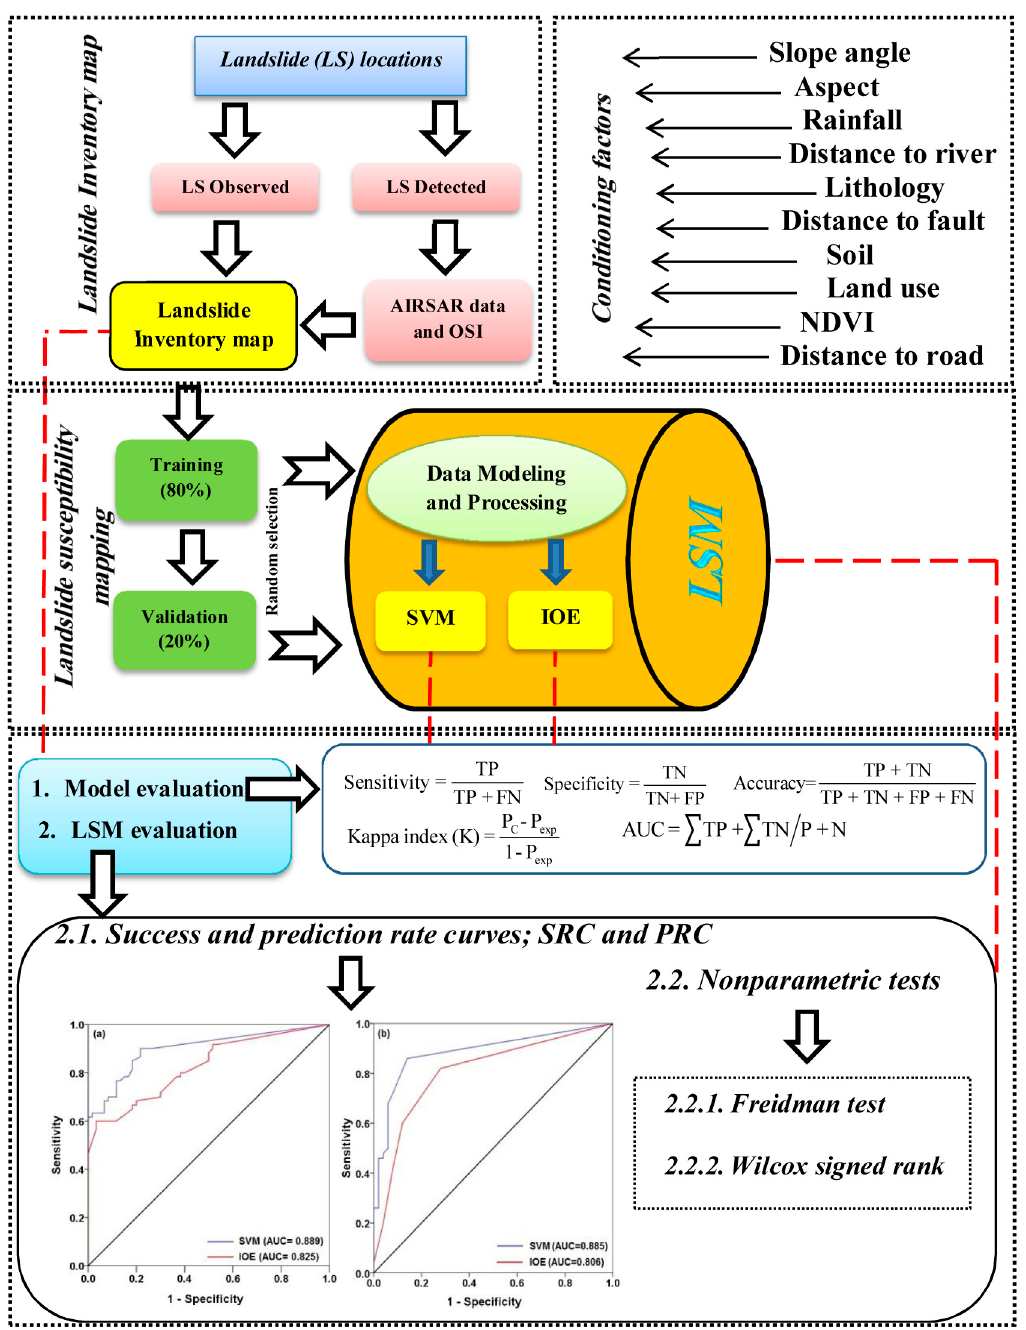
Figure 5. Flowchart of preparing the map for landslide susceptibility mapping. IOE, index of entropy.